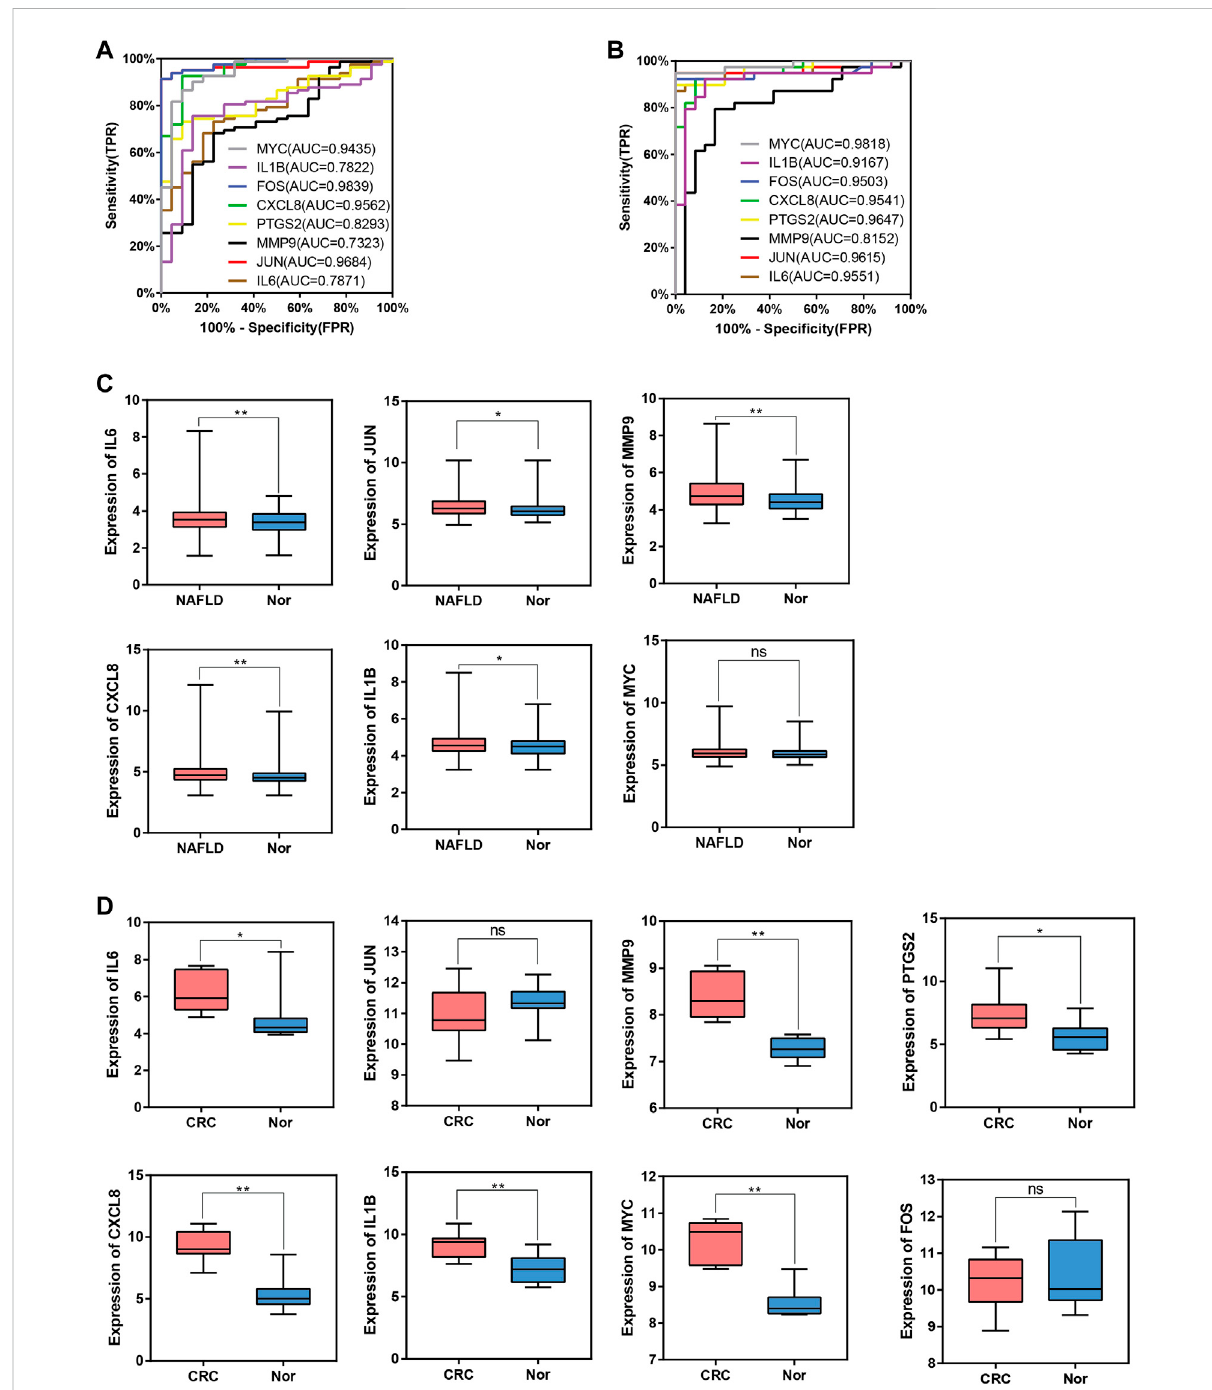
FIGURE 9 ROC curve and box plot of hub genes. (A) , The AUC of hub genes for the diagnosis of NAFLD in the ROC analysis of the GSE89632 dataset. (B) , The AUC of hub genes for the diagnosis of CRC in the ROC analysis of the dataset derived by integrating GSE4107 and GSE9348. (C) , The expression of hub genes in NAFLD vs. Normal group in the GSE163211 dataset. (D) , The expression of hub genes in CRC vs. Normal group in the GSE184093